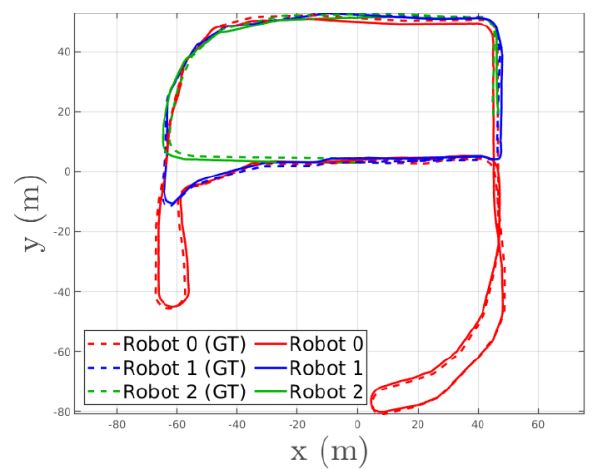
Figure 4. Estimated trajectories of Kimera-Multi [119] compared to the ground truth (GT). The absolute trajectory error (ATE) in that experiment was 1.46 m.